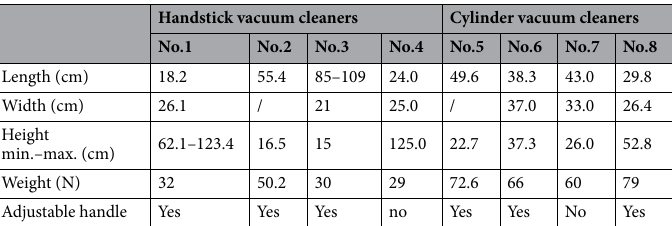
Table 1. Properties of the vacuum cleaners according to the manufacturers’